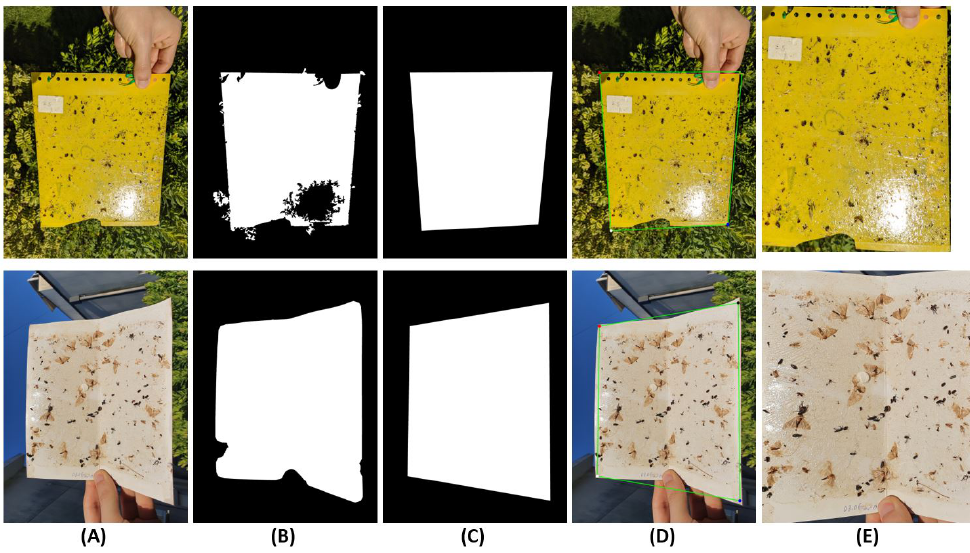
Figure 7. Perspective correction methodology: ( A ) original image; ( B ) trap segmentation mask; ( C ) segmentation mask from polygonal approximation; ( D ) corner points from polygonal approximation; ( E ) transformed image with corrected